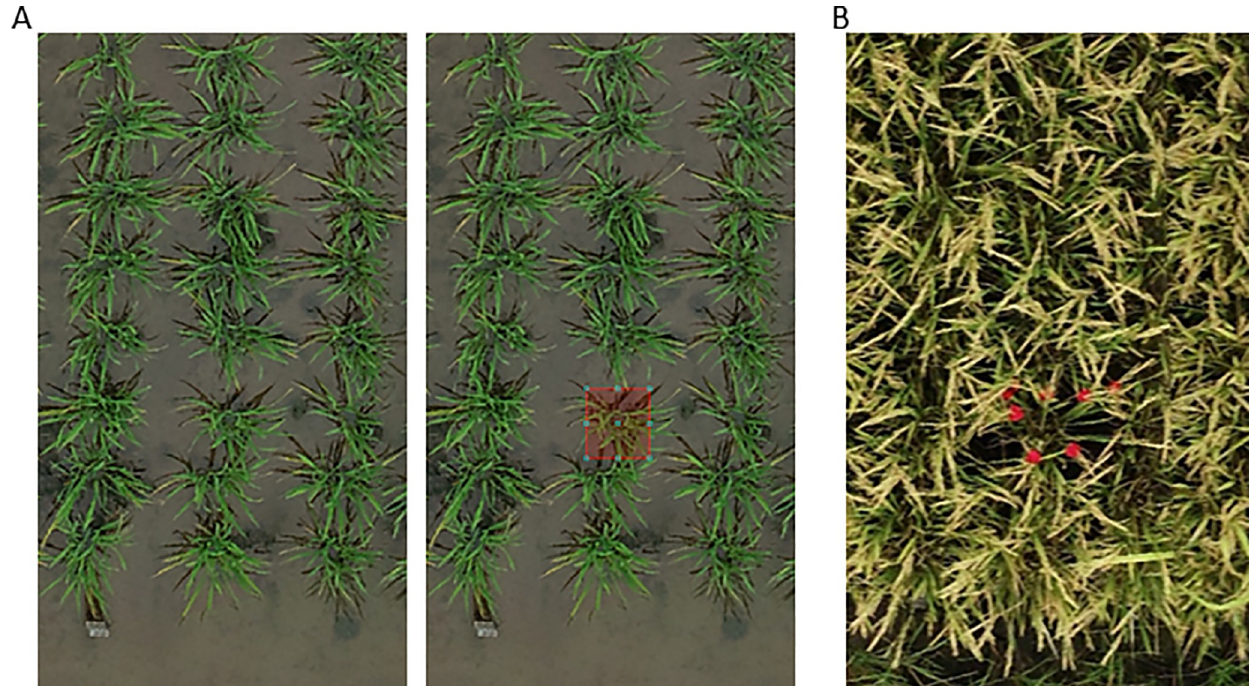
Fig 3. Detection of plant centers in orthomosaics at (A) vegetative stage and (B) reproductive stage. (A) The images were viewed in ENVI software and the position of the centers selected by eye were recorded using the software (left, before; right, after selection). (B) The positions of the red flags were selected by eye in ENVI software, and the average distance from the center to the red flags was calculated as PP.